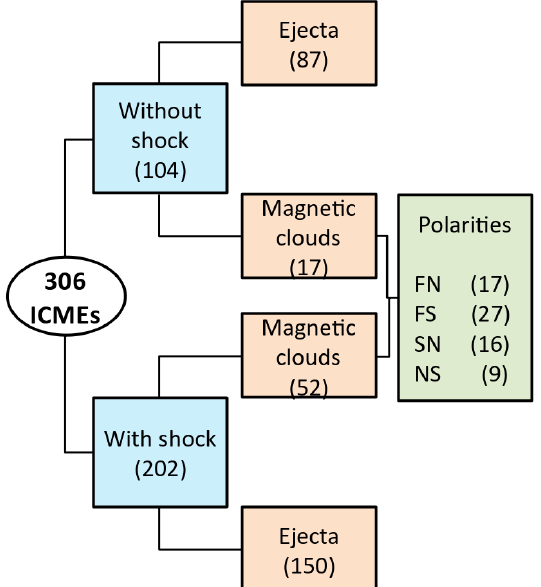
Figure 1. Organigram summarizing the distribution of ICMEs ac- cording to the presence of a shock upstream of the ICME (in blue), the magnetic structure of the event (in orange), and the polarity of magnetic clouds (in green). The numbers in parentheses indicate the number of events in each group. The different polarities are defined in Sect.